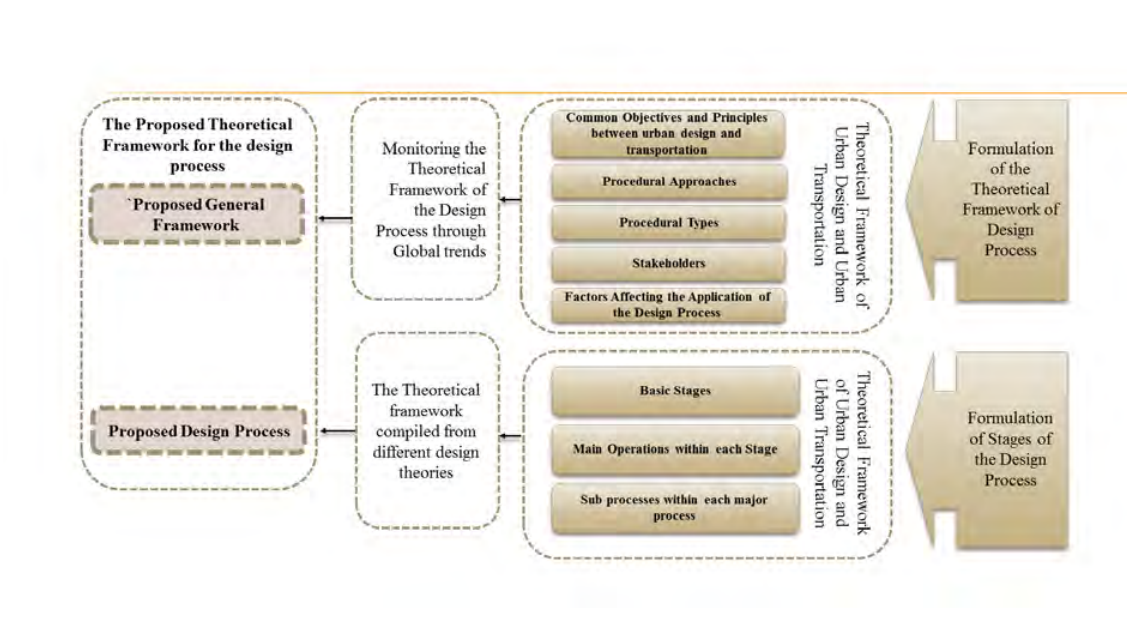
Figure 1. The frame derived from the urban design used in the first and second phases of the questionnaire. Source: (Mohammed, 2016, p.